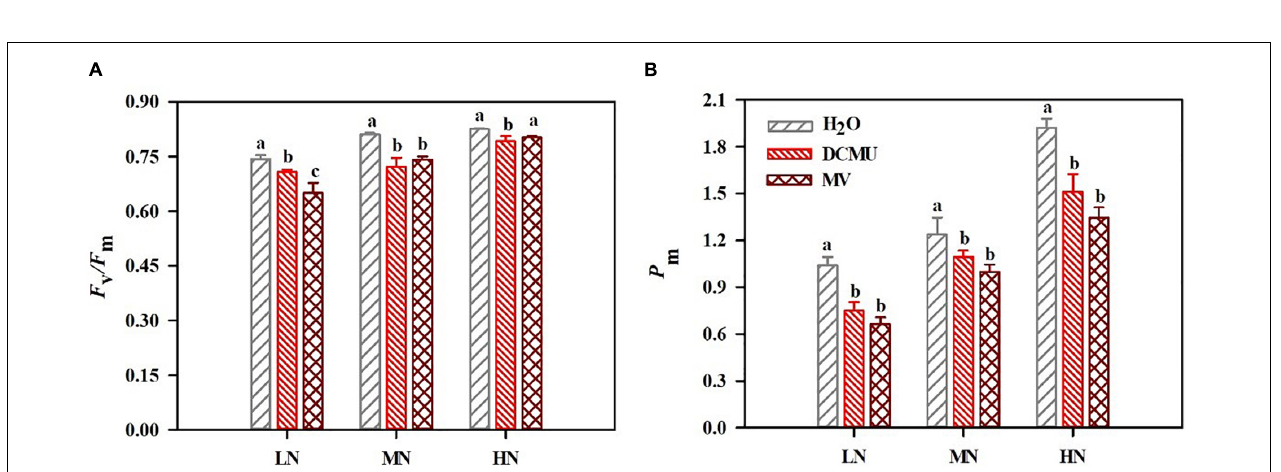
FIGURE 3 | Effects of 3-(3,4-dichlorophenyl)-1,1-dimethyl urea (DCMU) and methyl viologen (MV) on F v / F m (A) and P m (B) in leaves of Panax notoginseng grown under different nitrogen regimes. After infiltration with chemical reagents (H 2 O, DCMU, and MV) in darkness for 12 h. F v / F m , and P m were measured as described in the section “Materials and Methods.” Values for each point were mean ± SD ( n = 5). Different letters indicate significant differences among treatments ( p < 0.05, one-way ANOVA).